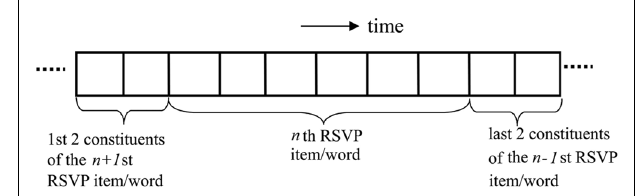
FIGURE 2 |A 10-slot delay-line with three RSVP items in progress through